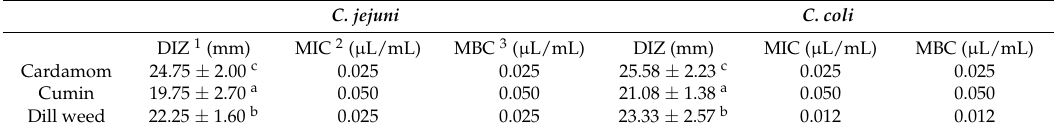
Table 2. DIZ, MIC, and MBC of essential oils against Campylobacter